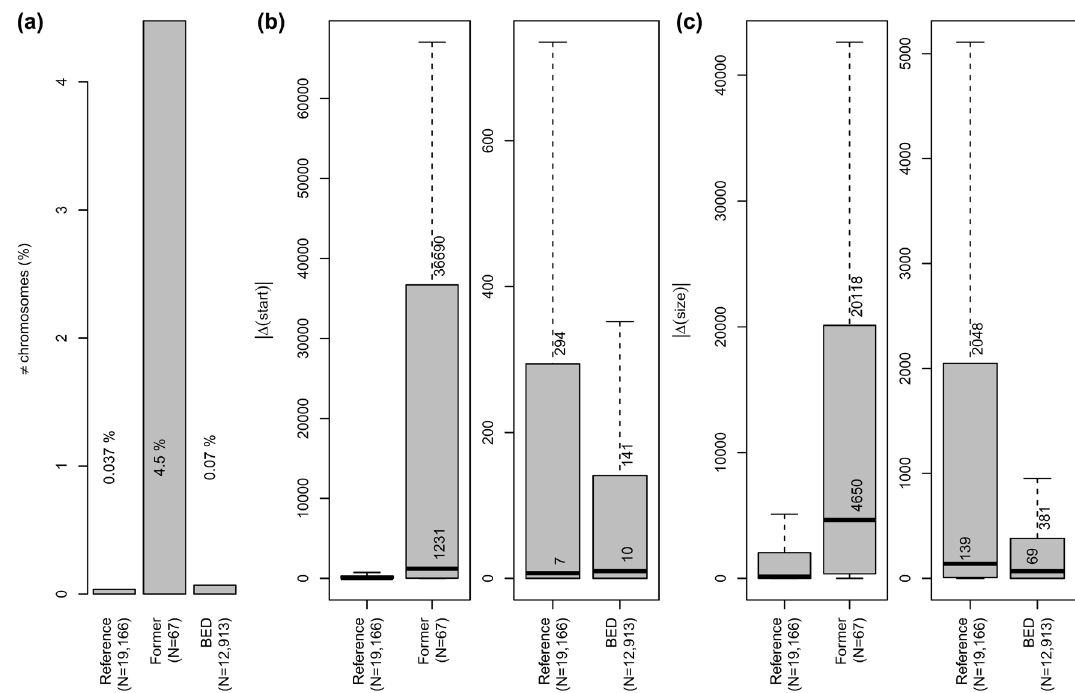
Figure 5. Comparison of gene locations provided by Ensembl for Ensembl identifiers and by the NCBI for the cross-referenced Entrez identifiers. “Reference” corresponds to mappings provided by biomaRt for identifiers successfully converted by all the tools. “Former” corresponds to mappings provided by mygene for identifiers successfully converted by mygene but neither by biomaRt nor BED. “BED” corresponds to mappings provided by BED for identifiers successfully converted by BED but not by any of the three other tools. Numbers of considered mappings (N) in each group are indicated (see text for details). a ) Proportion of cross-referenced identifiers located on different chromosomes. b ) Absolute distance (base pairs) between gene start positions for cross-referenced identifiers located on the same chromosome. c ) Absolute difference (base pairs) between gene sizes for